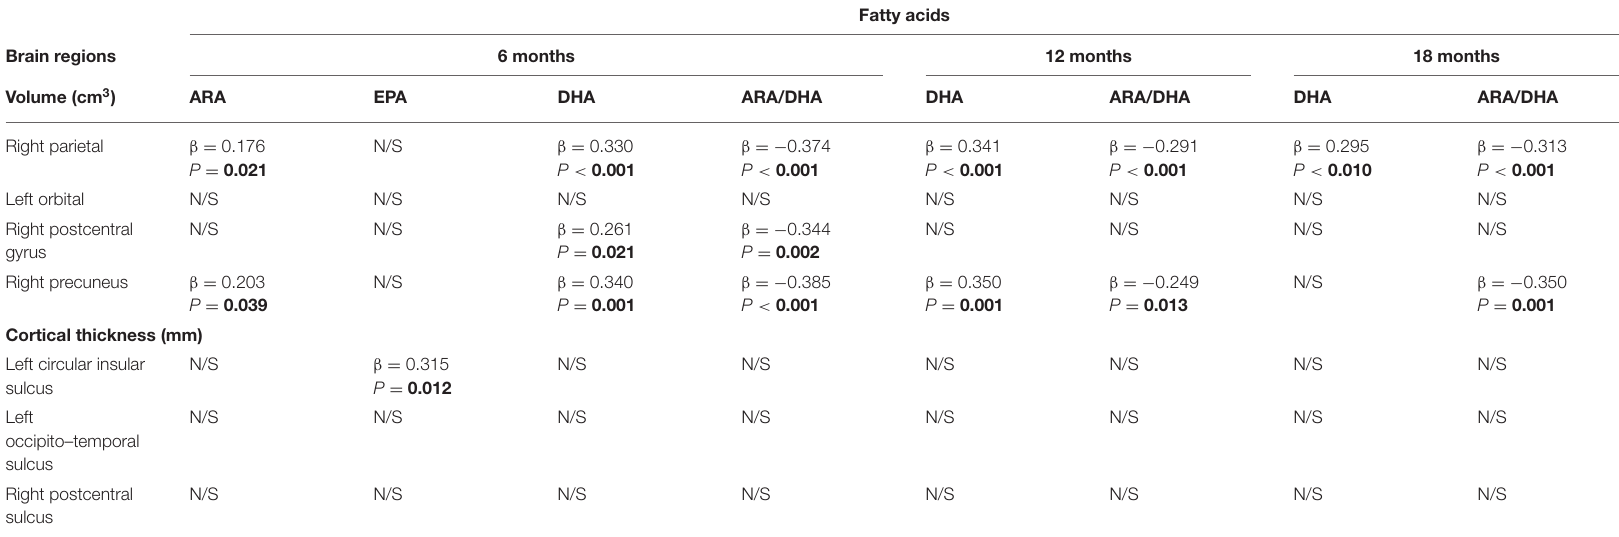
a P-values for linear regression analysis. P-values < 0.05 are highlighted in bold. ARA, Arachidonic acid; EPA, Eicosapentaenoic acid; DHA, Docosahexaenoic acid; ARA/DHA, Arachidonic acid/Docosahexaenoic acid ratio; β , Beta coefficient; N/S, Not